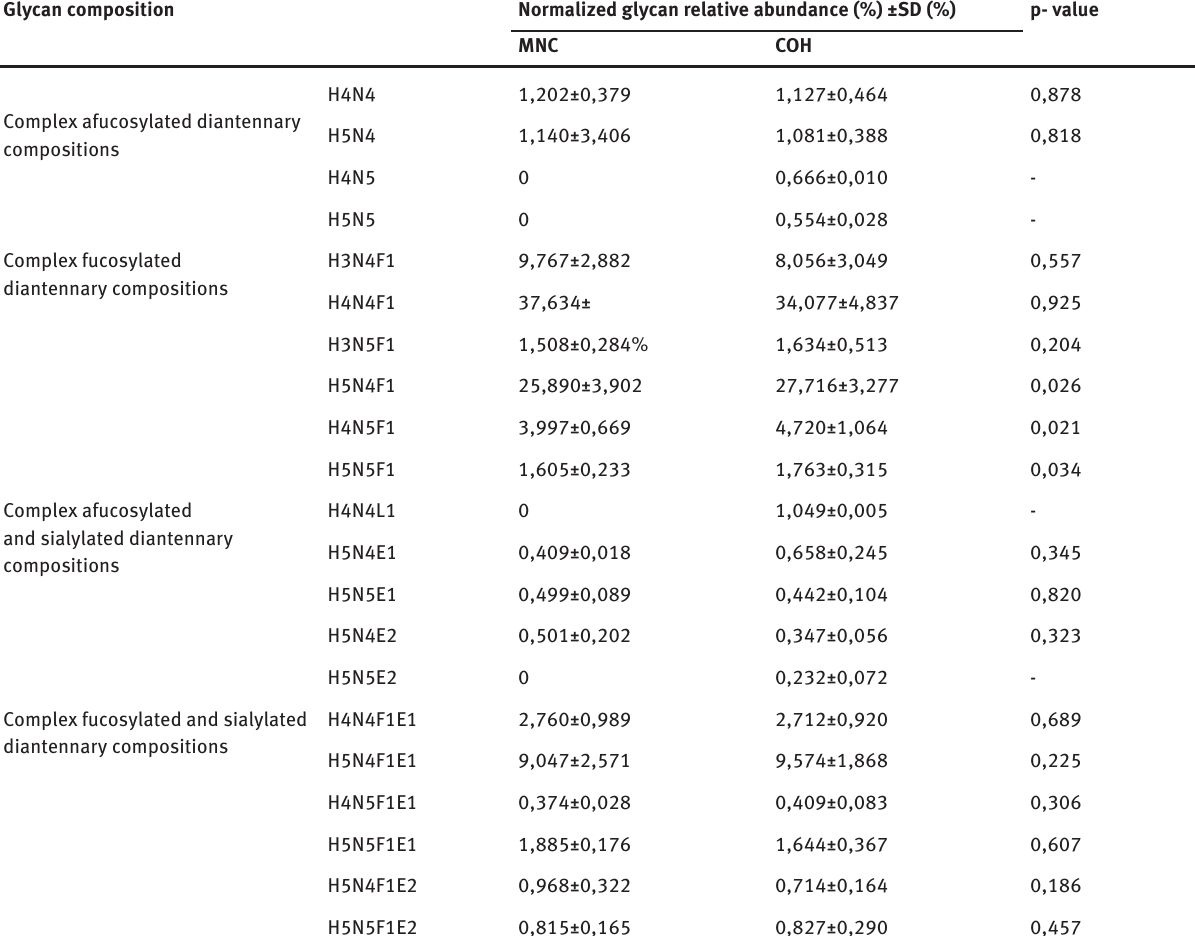
Table 2: The list of identified N-glycan compositions and their normalized relative abundances (expressed as means ± SD; %) in the FF IgG N-glycomes of the MNC and COH groups of patients. The pairwise differences in individual glycans relative abundances between analyzed groups were considered significant at the p<0,05 (Mann-Whitney U test). Glycan compositions were assigned and associated mass errors were calculated by using GlycoMod platform (29) (http://web.expasy.org/glycomod/) with mass tolerance set to 0.2 Da.